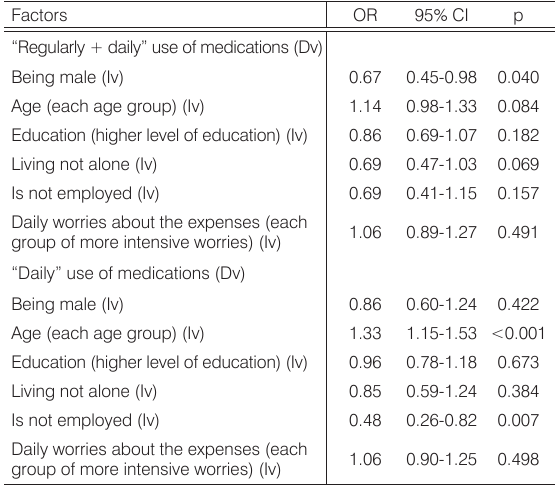
Table 2. Odds ratios for use of medications “regularly + daily” and “daily”, logistic regression